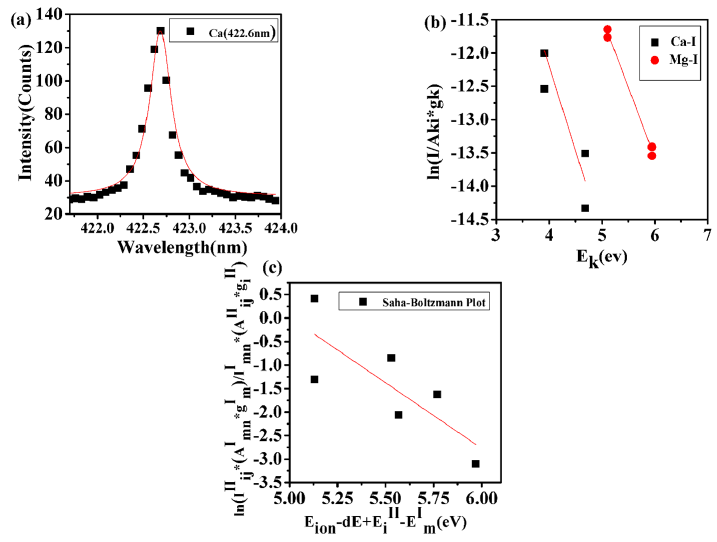
Figure 4. ( a ) Lorentzian plot for determination of electron density. ( b ) Boltzmann plot for determi- nation of plasma excitation temperature. ( c ) Saha–Boltzmann plot for determination of ionization temperature. Excitation and ionization temperature agree within 11%, confirming local thermody- namic equilibrium; see text.